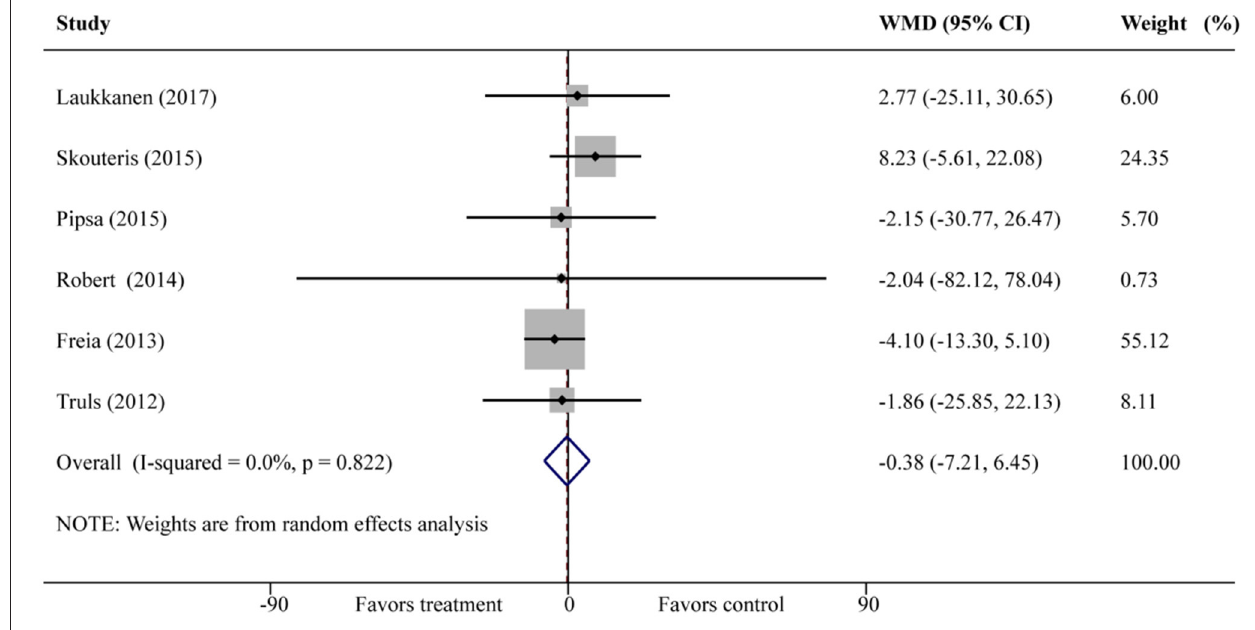
FIGURE 5 | Forest plot of family intervention on SB in children aged 2.5–12 years.